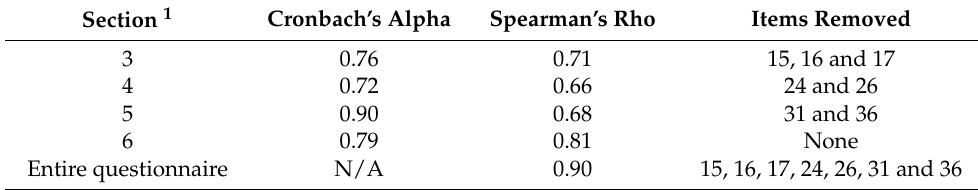
Table 2. Cronbach’s alpha and Spearman’s rho by section of the final questionnaire.